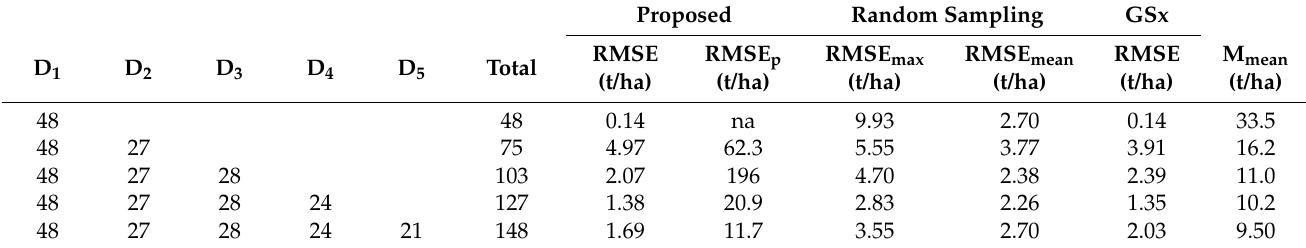
Table 2. Dry mass estimation results using the proposed methodology, the greedy sampling and the random sampling approaches. The first five columns express, for each date, the number of samples exploited for PLSR model calibration, with the red-framed cell indicating the prediction date. Results are expressed in terms of the root mean squared error RMSE. The values RMSE p refer to predictions made using a model calibrated with data acquired up to D i − 1 . The last column of the table refers to the average dry mass for each date. D 1 : 15 May 2014, D 2 : 14 October 2014, D 3 : 9 May 2017, D 4 :